Question: Provide a one-line summary of what is displayed.
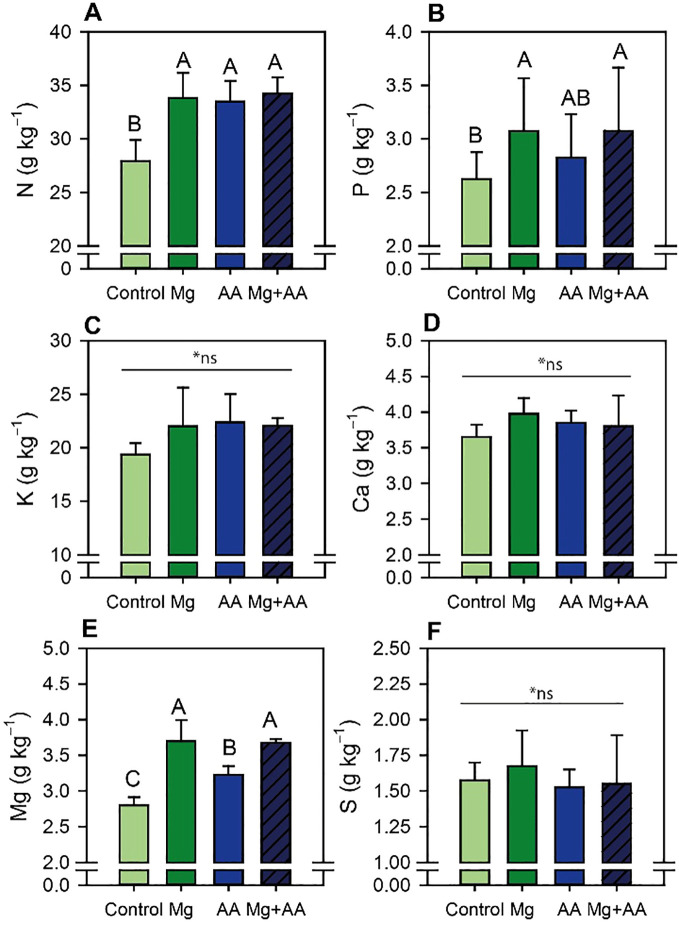
Answer: Leaf macronutrient levels in maize plants as affected by the foliar application of magnesium (Mg) and/or amino acids (AA): (A) N, (B) P, (C) K, (D) Ca, (e) Mg, and (f) (S) Bars represent means across the 2021 and 2022 off-season growing periods. Different letters indicate significant differences among treatments (LSD, p ≤ 0.05). ns, not significant. Error bars represent standard deviation (n = 8). *ns, not significant.